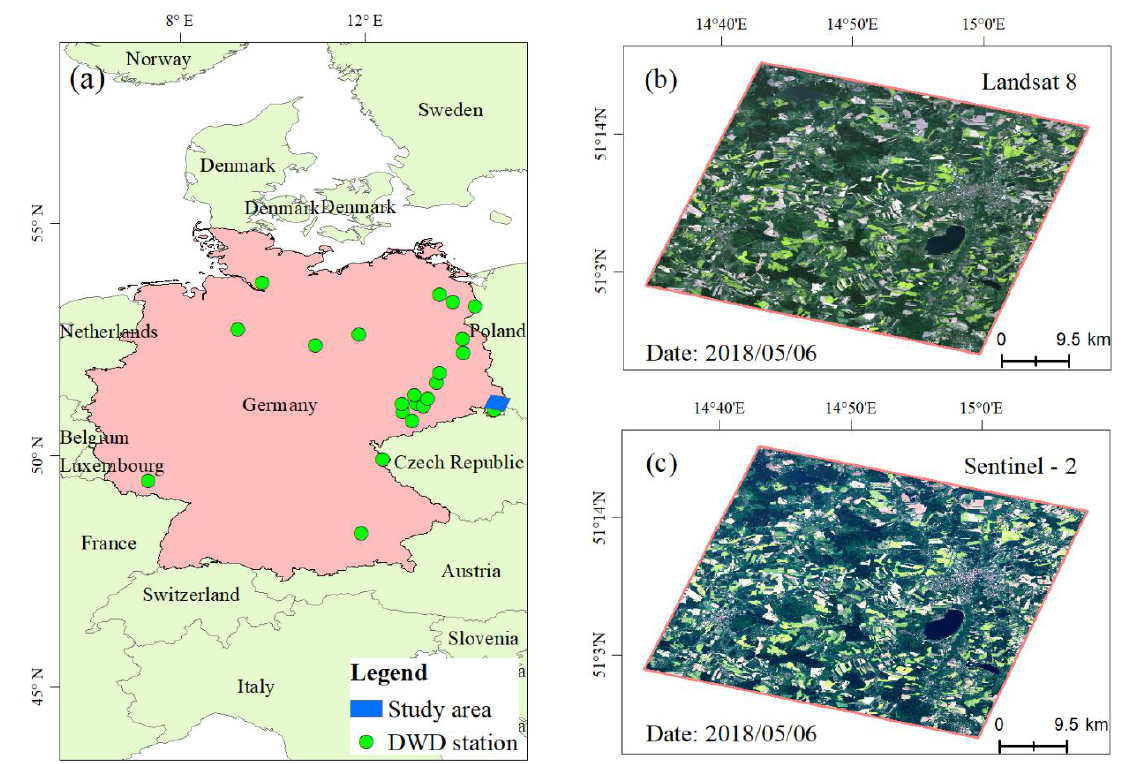
Figure 2. Germany’s National Meteorological Service (the Deutscher Wetterdienst, DWD) stations of rapeseed ( a ), Landsat 8 ( b ), and Sentinel-2 ( c ) images during the flowering period of rapeseed. The true color composites (R/G/B = Band4/Band3/Band2) from Landsat 8 OLI and Sentinel-2 images.